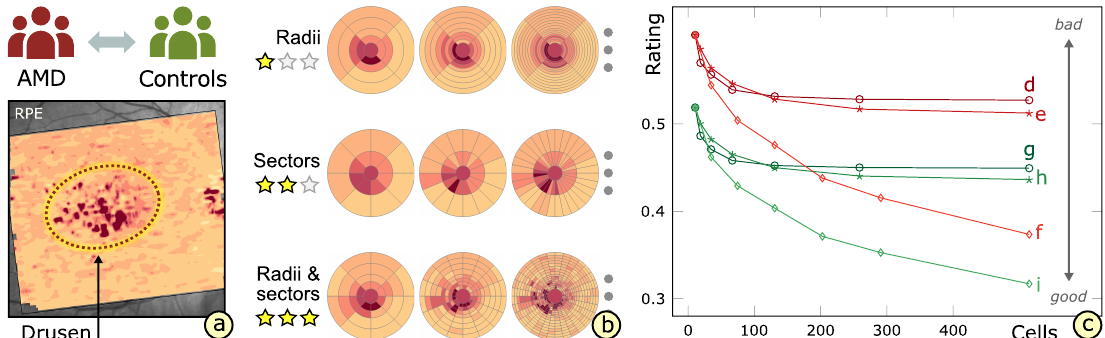
Figure 10. The experimental study setup and results in AMD patients and matched controls. Drusen are indicated by localized thickening in lower retinal layers of patient eyes ( a ). Examples of evaluated grids show increasingly finer subdivision of cells ( b ). The line plot ( c ) illustrates ratings of grids with respect to cell counts for thickness data of patients (red) and controls (green) in relation to three partitioning strategies: radial ( d,g ), sector-wise ( e,h ), and radial and sector-wise ( f,i